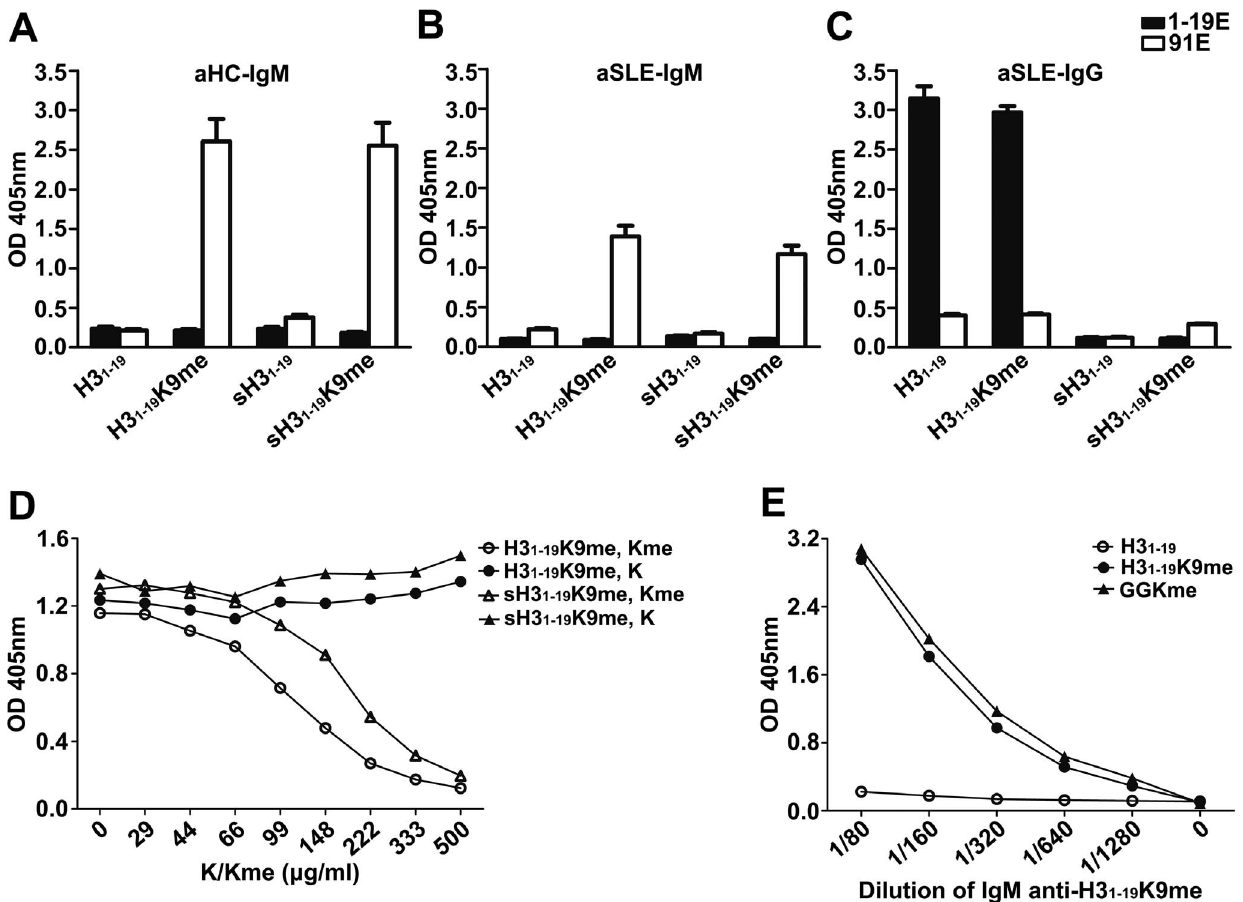
Figure 6. Epitope analysis for IgG and IgM purified from the H3 1 – 19 or H3 1 – 19 K9me beads. (A), (B) and (C) Microtiter plates were coated with H3 1–19 , H3 1–19 K9me, scrambled H3 1–19 (sH3 1–19 ) and scrambled H3 1–19 K9me (sH3 1–19 K9me) conjugated to BSA. IgM of healthy adults from the IgG(1–19 low 91 low )IgM(1–19 high 91 high ) subgroup, IgM of aSLE patients from the IgG(1–19 low 91 low )IgM(1–19 high 91 high ) subgroup and IgG of aSLE patients from the IgG(1–19 high 91 x )IgM(1–19 x 91 x ) subgroup were tested. KT16 anti-human IgM mAb and KT47 anti-human IgG were used as the primary Abs. HRP-conjugated goat anti-mouse IgG was used as the secondary Ab. 1–19E, Abs eluted from the H3 1–19 beads; 91E, Abs eluted from the H3 1–19 K9me beads. Data are expressed as mean + SEM. (D) Microtiter plates were coated with H3 1–19 K9me or sH3 1–19 K9me conjugated to BSA. IgM Abs of healthy adults from the IgG(1–19 low 91 low )IgM(1–19 high 91 high ) subgroup were incubated with lysine (K) or e -amine mono-methylated lysine (Kme) at indicated concentrations for 1 h at room temperature. KT16 anti-human IgM was used as the primary Ab. HRP-conjugated goat anti-mouse IgG was used as the secondary Ab. (E) Microtiter plates were coated with H3 1–19 , H3 1–19 K9me and GGK(me)GGSGGSGGSG (GGKme) conjugated to BSA. IgM of healthy adults from the IgG(1–19 low 91 low )IgM(1–19 high 91 high ) subgroup was tested. KT16 anti-human IgM was used as the primary Ab. HRP-conjugated goat anti-mouse IgG was used as the secondary Ab. The results are representative of three separate